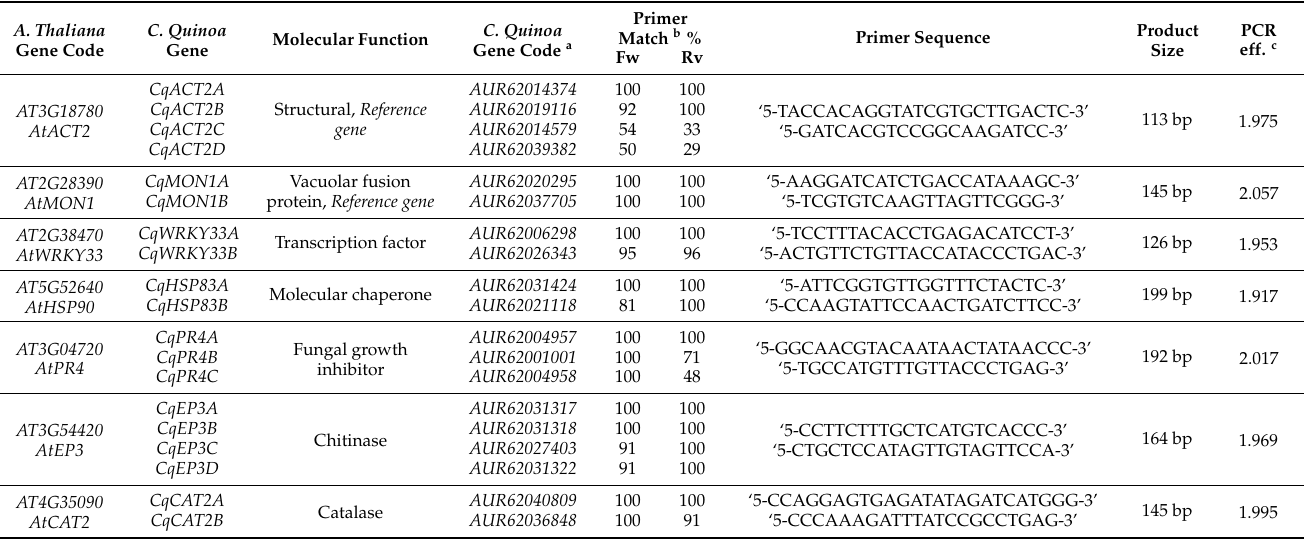
Table 1. C. quinoa genes with their respective A. thaliana ortholog-codes and primer sequences for qRT-PCR